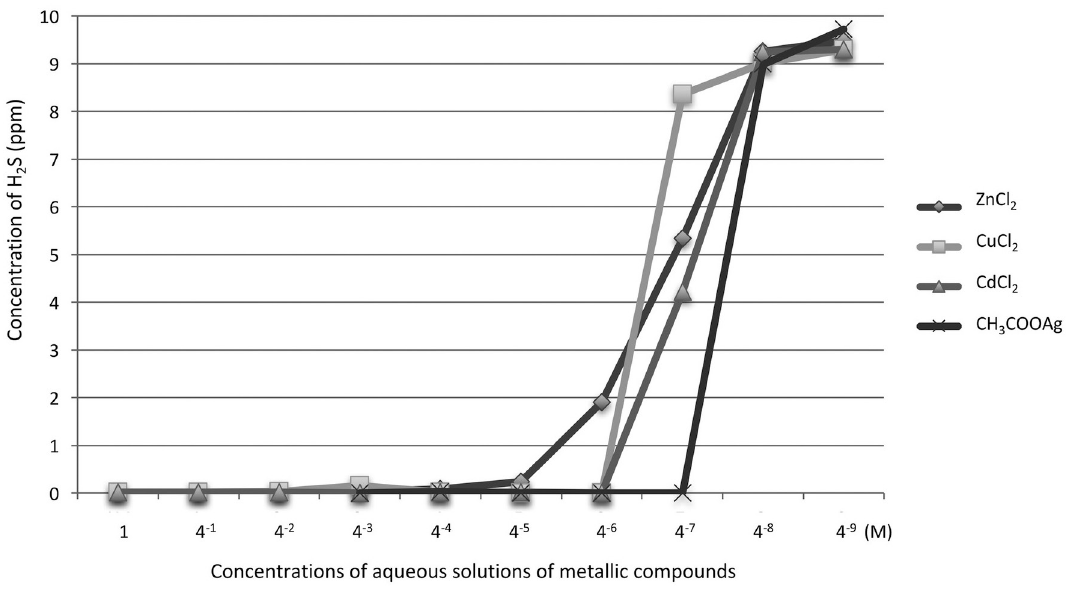
S volatilization using serially diluted aqueous solutions of ZnCl 2